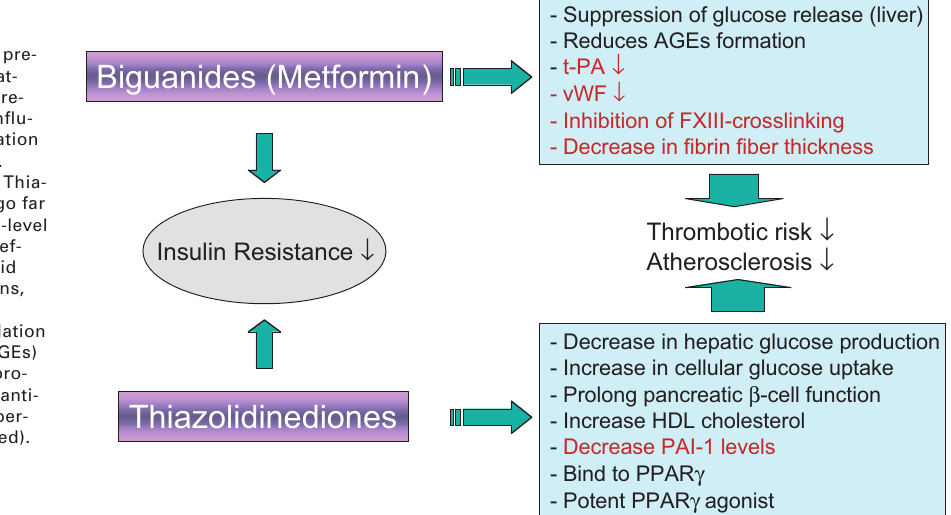
Therapeutic ap- proaches in the pre- vention and treat- ment of insulin-re- sistant states: Influ- ence on coagulation and fibrinolysis. Biguanides and Thia- zolidinediones go far beyond glucose-level lowering. Such ef- fects include lipid modifying actions, reduction in ad- vanced glycosylation endproducts (AGEs) formation and pro- fibrinolytic and anti- thrombotic proper- ties (shown in